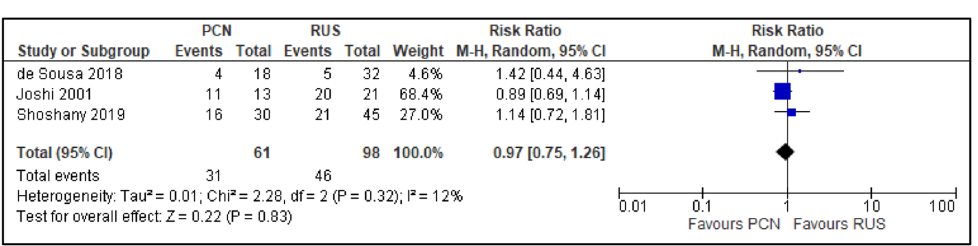
Figure 10. Comparison between PCN and RUS for outcome QoL –